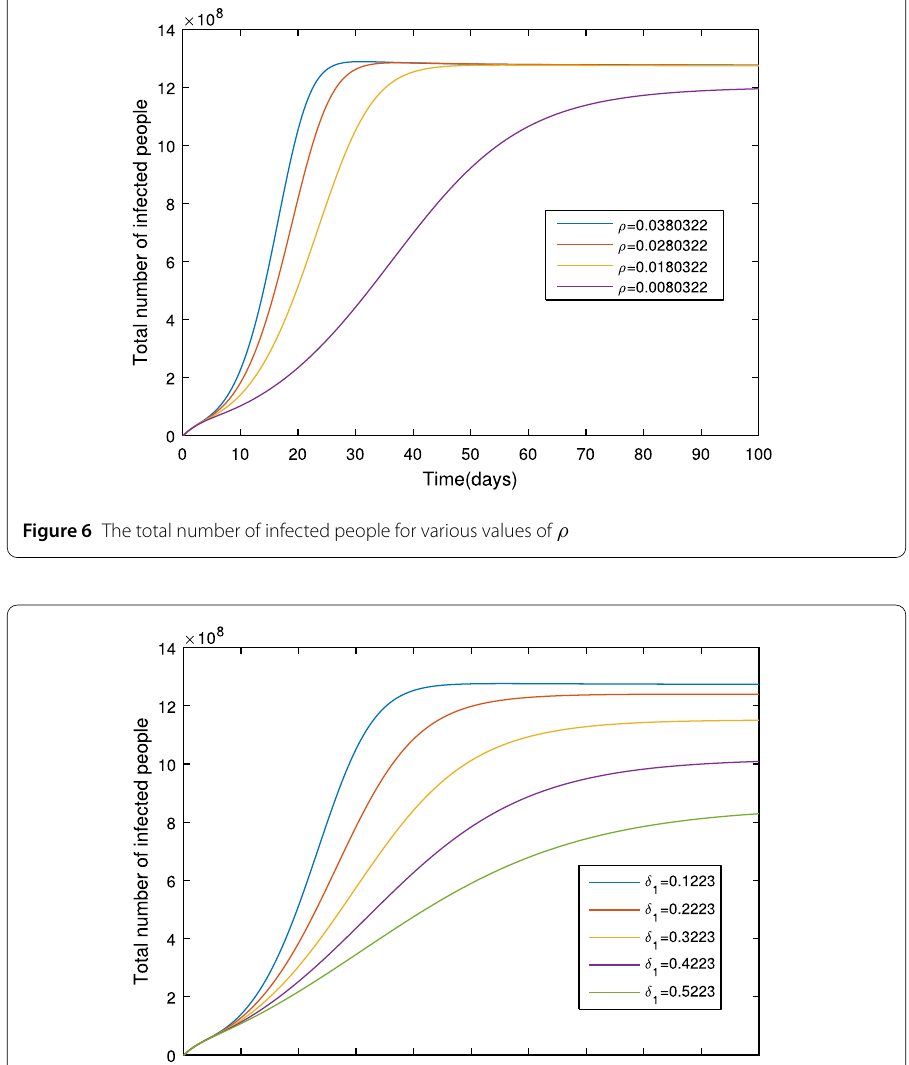
α α 1 = 2 = 1,0.96,0.92,0.88. In these figures with different values of the fractal-fractional operators, a novel analysis and a variety of choices for choosing the fractal and fractional order parameters is extensively illustrated, which is the beauty of the fractal-fractional op- erator. One can see that the modeling of a real-life problem with fractal-fractional operator is more useful than that with the ordinary derivative. The infected data and its comparison with proposed model and the possible elimination of the infection can be assessed well with this new fractal-fractional operator. Our results suggest that, when decreasing the values of both the fractal and fractional order, one can see a decrease in the infected com- partment, which is better than for the integer-order compartment. The suggested fractal and fractional order values are arbitrary, and one can choose any value to simulate the